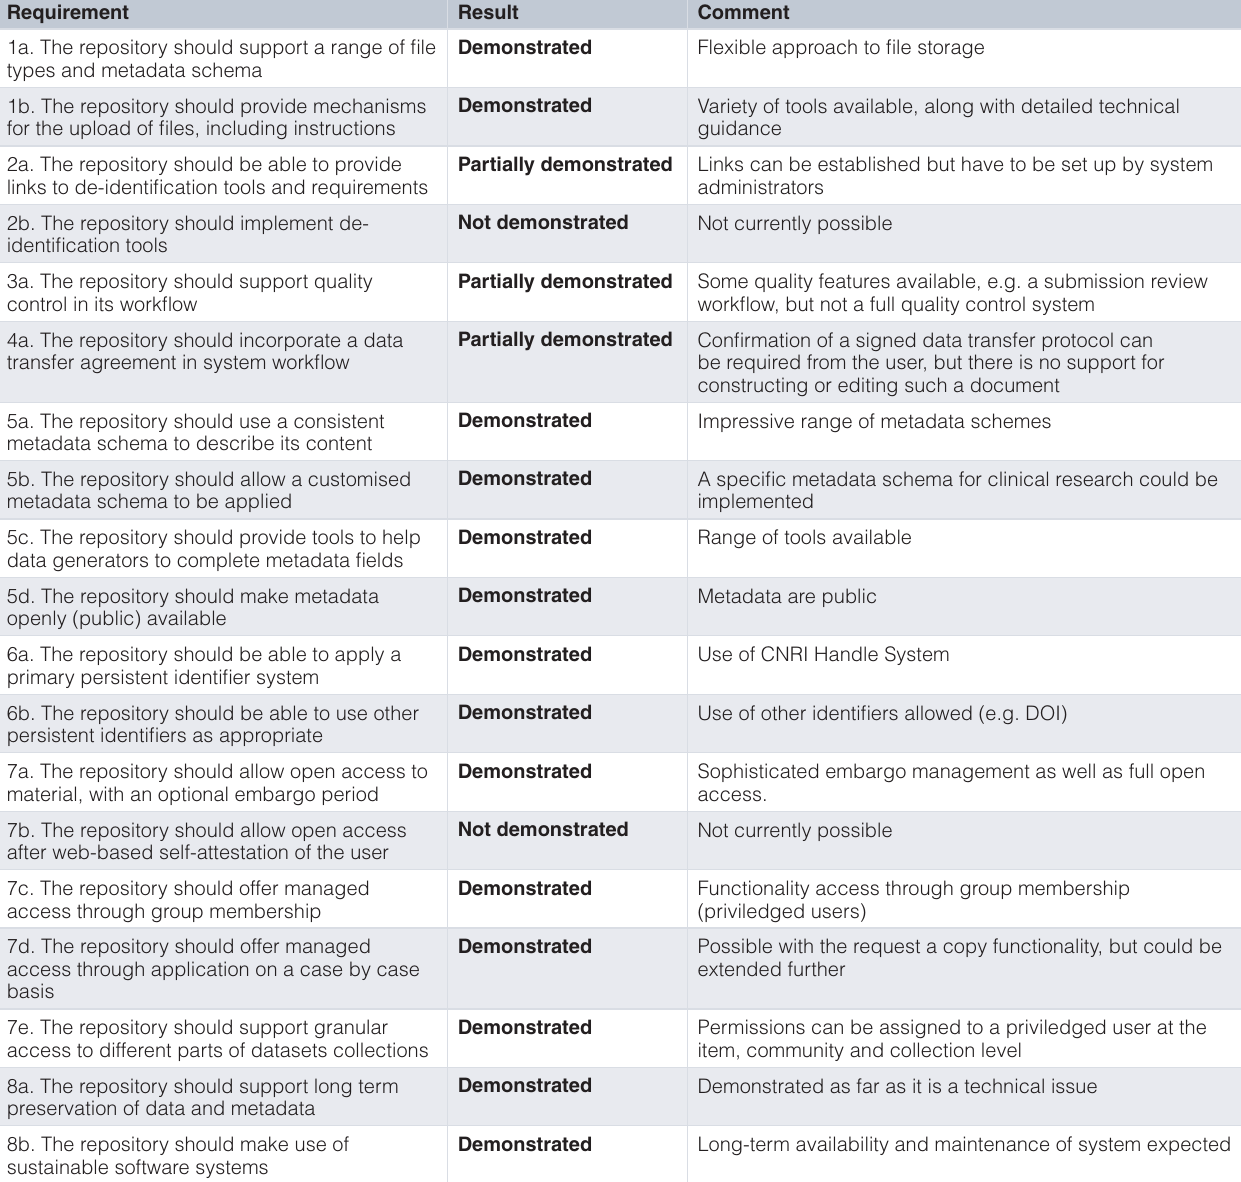
Table 2. Summary of the assessment of quality criteria and the